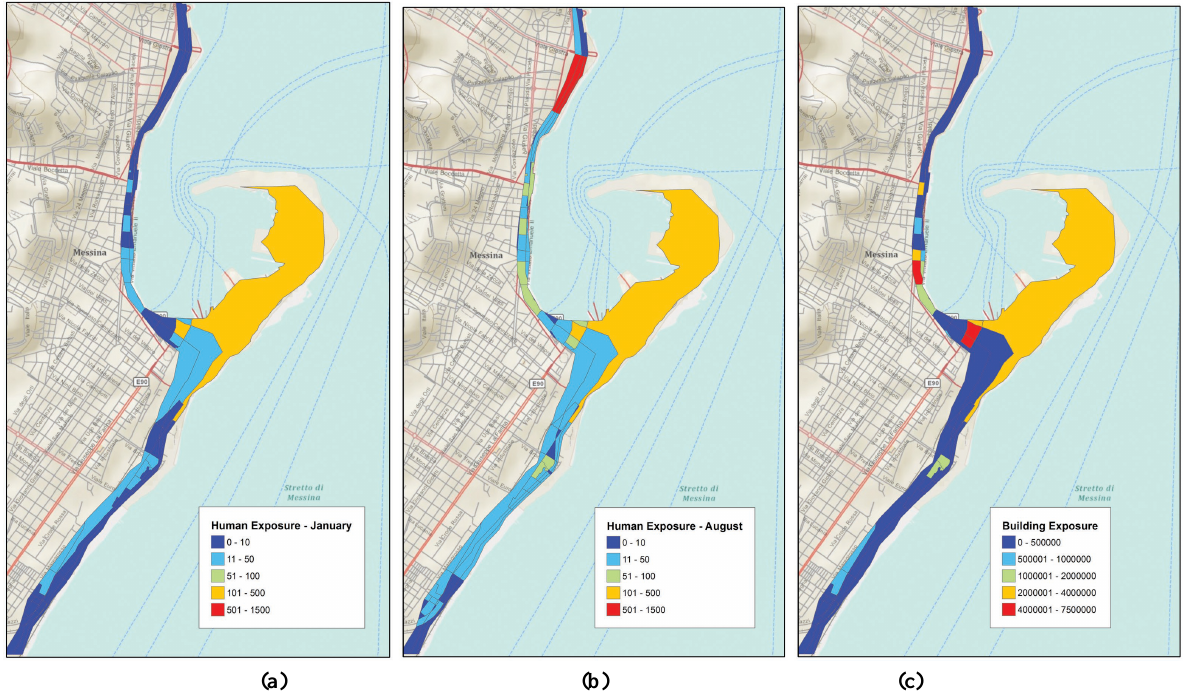
Fig. 4. Human Exposure HE j in terms of number of persons (a) in January and (b) in August, and (c) Building Exposure BE j i economic value (Euro) in each j -th section fraction in the i -th TRZ i ( j = 1 , 54 and i = 1 , 2 , 3).